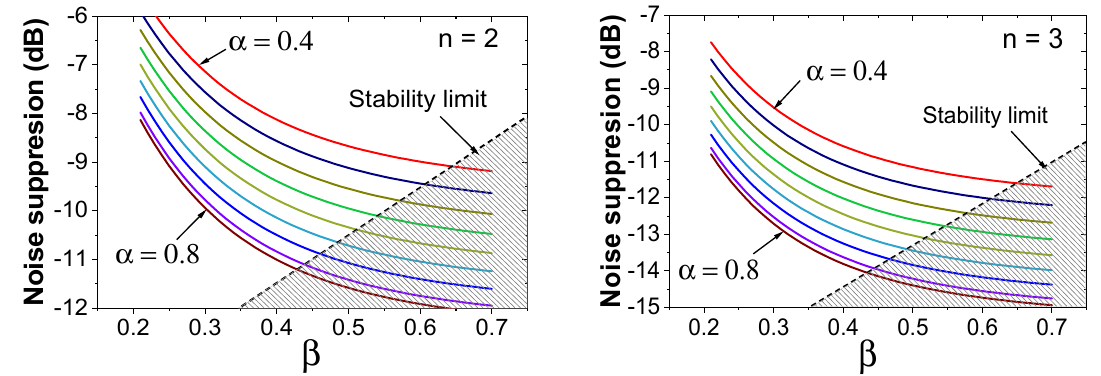
Figure 5. Noise suppression as a function of β for various α values.